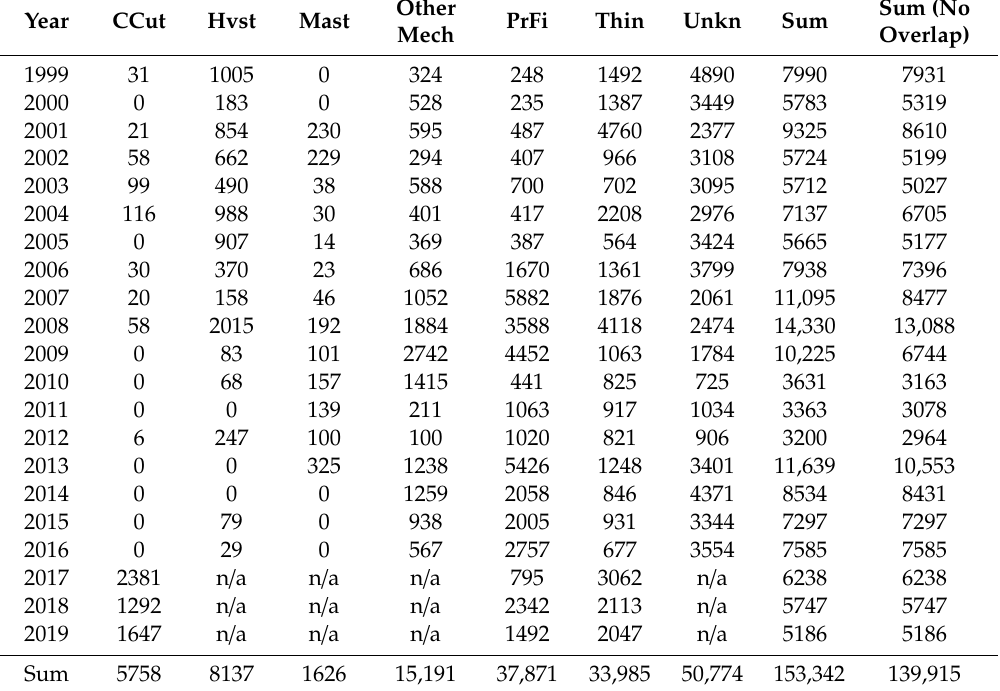
Table 3. Area of forest treatment types for each year of the 21-year study period, estimated in hectares. The column “Sum” summarizes the total treated area per year. It includes overlapping polygons for the period 1999-2014 (LANDFIRE Model Ready Events) of the same treated polygon. The column “Sum (no overlap)” removed overlapping treatments for the same treated polygon. CCut: Clearcut;